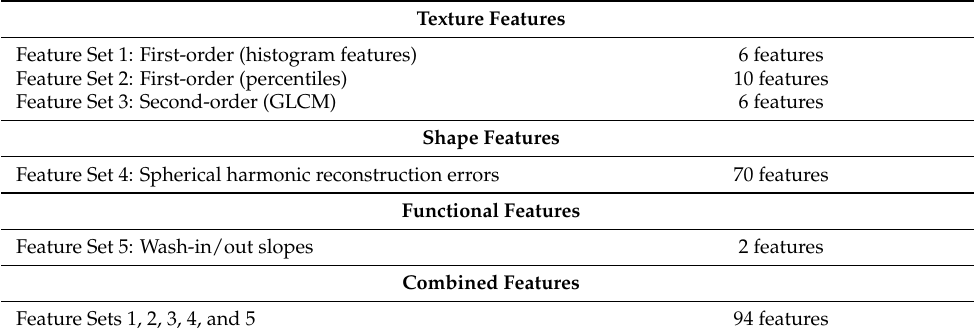
Table 2. Details of the extracted feature sets used in the two-stage renal tumor